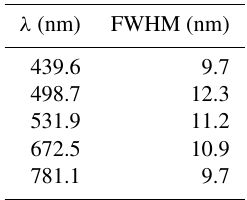
Table 1. Central wavelength and FWHM of the sun photometer (SSARA-Z) filters used for AOD